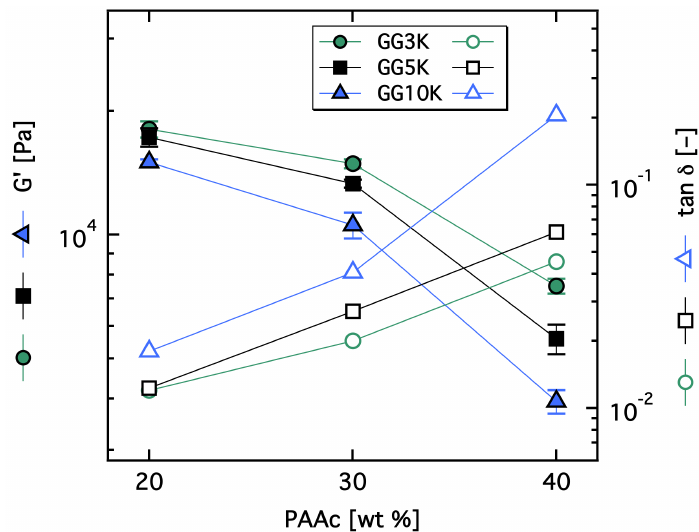
Figure 5. Storage modulus ( G (cid:48) ) and loss tangent (tan δ ) as a function of grafted PAAc content of the fully swollen hydrogels.